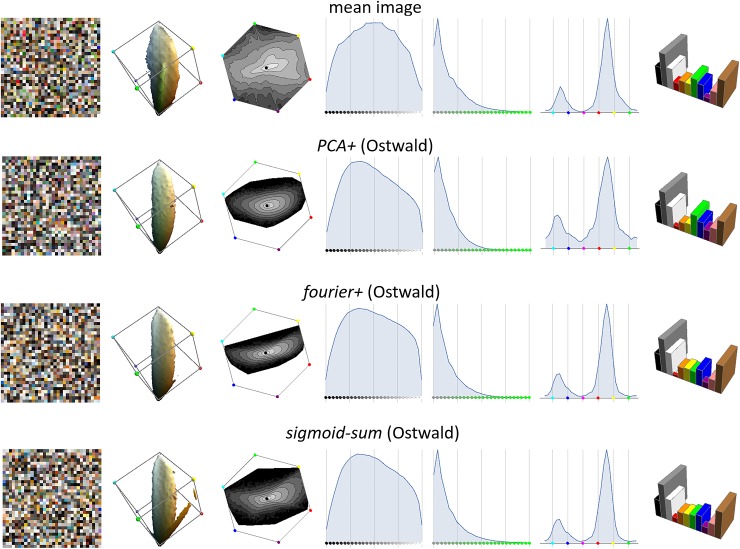
Same layout as Figs 8 & 13.